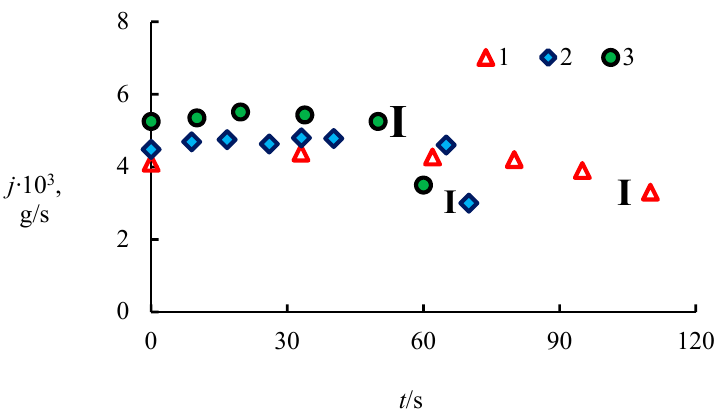
Figure 4. The dissociation rate j = Δ m / Δ t over time ( m 0 —initial powder mass): 1 − U 0 = 0 mm/s; 2 − U 0 = 0.2 m/s; and 3 − U 0 = 0.6 m/s ( I —maximum error interval).